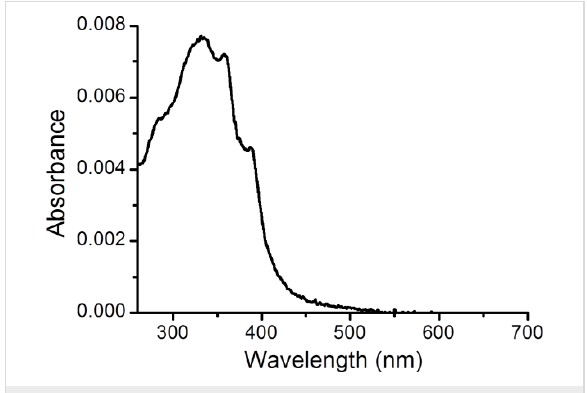
Figure 6: Absorbance of a monomolecular Langmuir–Blodgett film of 1 transferred at 16 mN·m − 1 onto a quartz substrate during the with- drawal of the substrate from the water subphase.